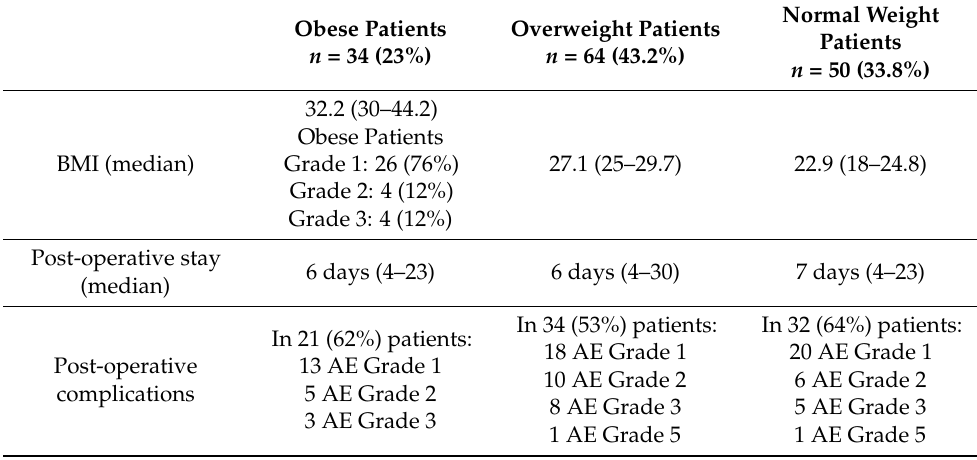
Table 4. Postoperative results according to the BMI class after lung resection by robotic surgery.